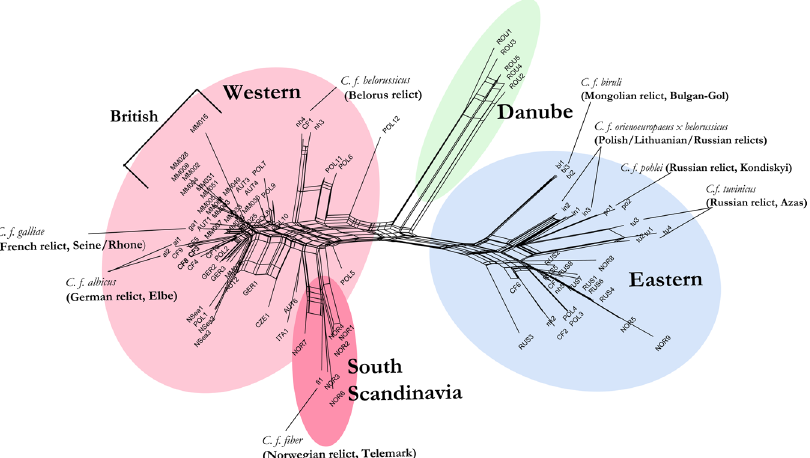
Figure 2. Neighbour-net network showing relationships among ancient British and modern and ancient beavers. Data is comprised of partial (492 bp) tRNAPro-Control regions mitochondrial haplotypes and comprise haplotypes generated here (prefixed ‘MM’), ancient haplotypes generated by Horn et al . 26,48 and modern relict population haplotypes previously described by Ducroz et al . 23 , Durka et al . 24 and Senn et al . 14 . British data are clustered closely together within the Western ESU and show no level of genetic distinctiveness from other Western